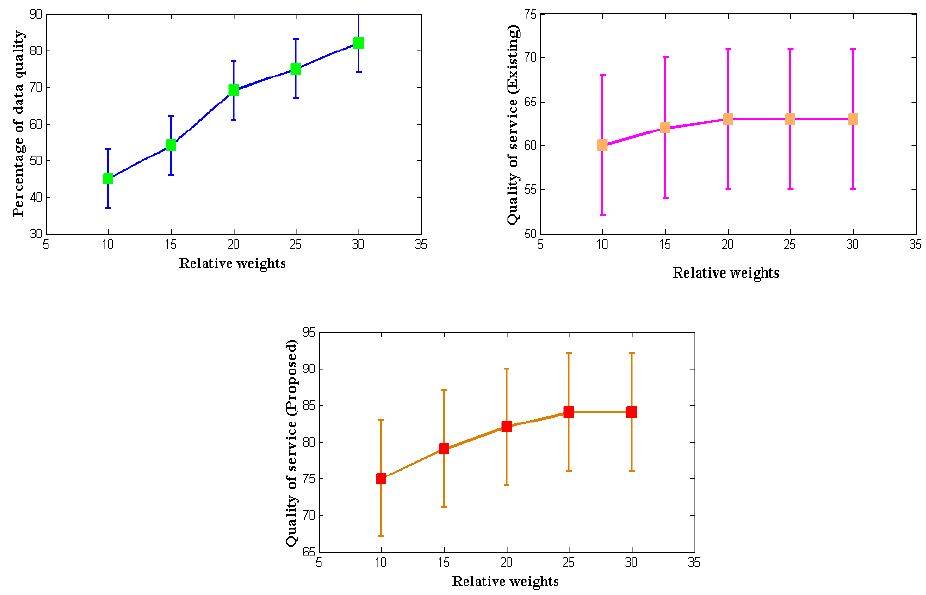
Figure 6. Quality of service measurements. Table 7. Quality of service with a relative weighting factor.